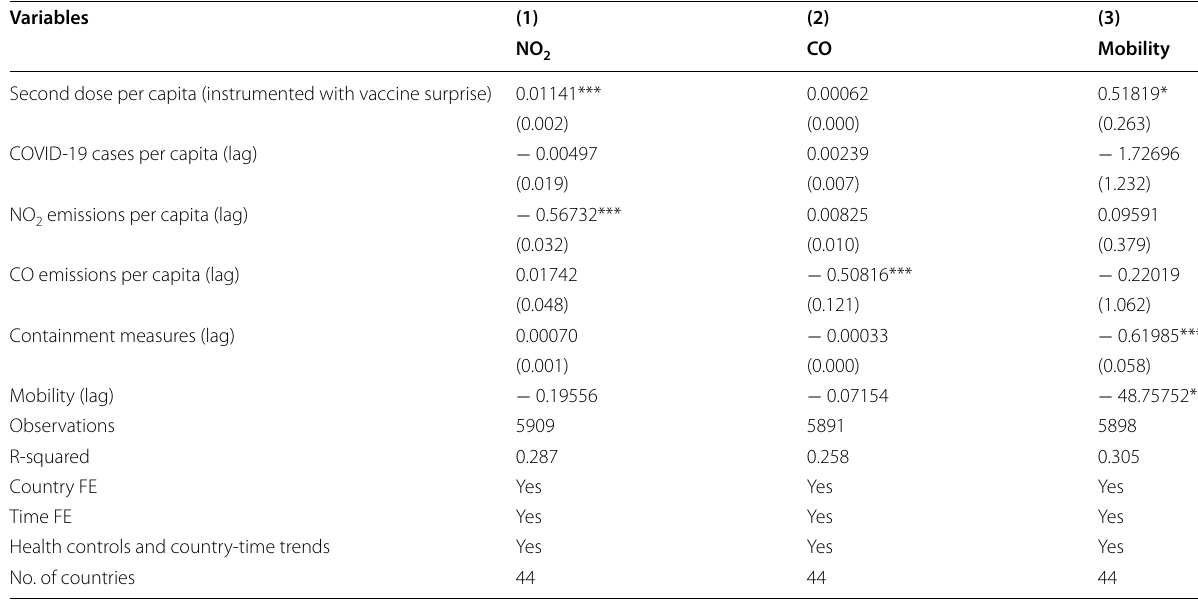
Table reports results for Eq. (1) but instruments for the share of fully vaccinated individuals with the vaccine surprise variable. The dependent variable is NO 2 emissions per capita for column 1, CO emissions per capital for column 2, and change in retail and recreation mobility for column 3. The regressions control for stringency